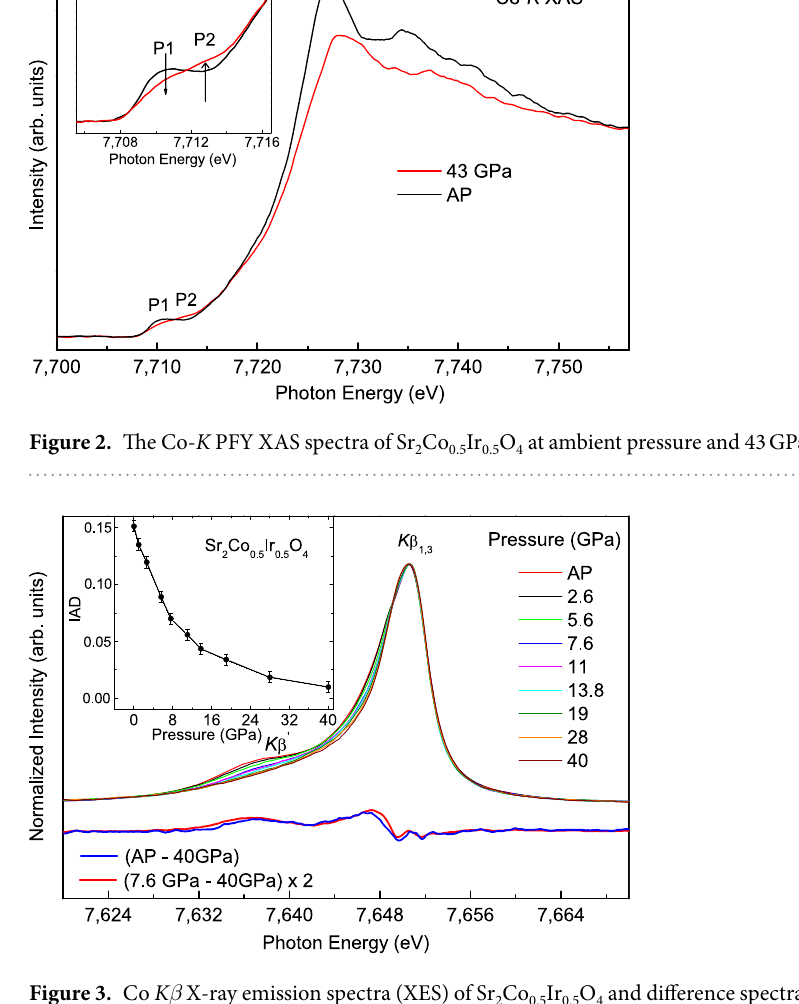
Figure 3. Co K β X-ray emission spectra (XES) of Sr 2 Co 0.5 Ir 0.5 O 4 and difference spectra of Co K β emissions between ambient pressure (AP) and 40 GPa (blue line) and between 7.6 and 40 GPa (red line). Inset: